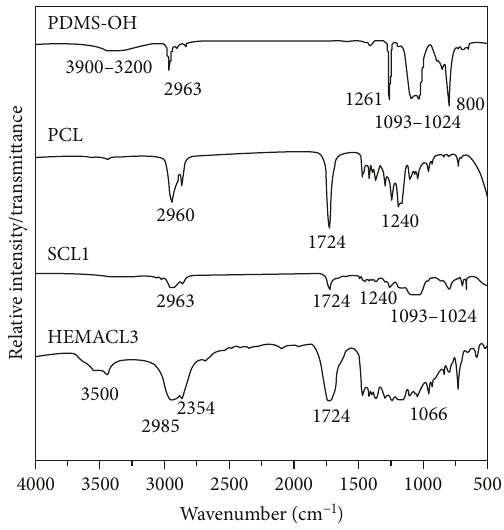
Figure 1: FTIR spectra of PDMS-OH, linear PCL, P (DMS- b - ε -CL) SCL1, and P (HEMA- co -(HEMA- g - ε -CL)- b - ε -CL)